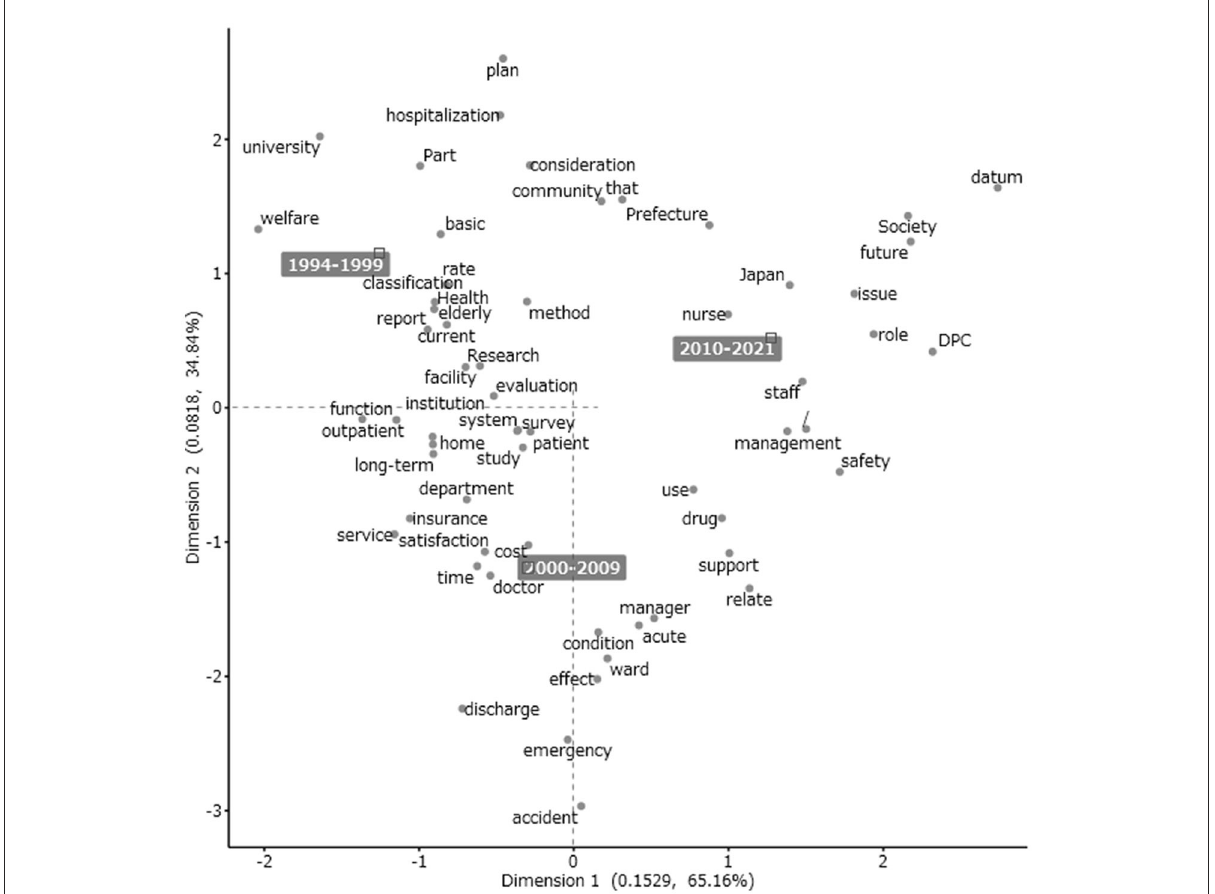
FIGURE2 Correspondence analysis (dimension 1 [time] and dimension 2 [abstract/concrete